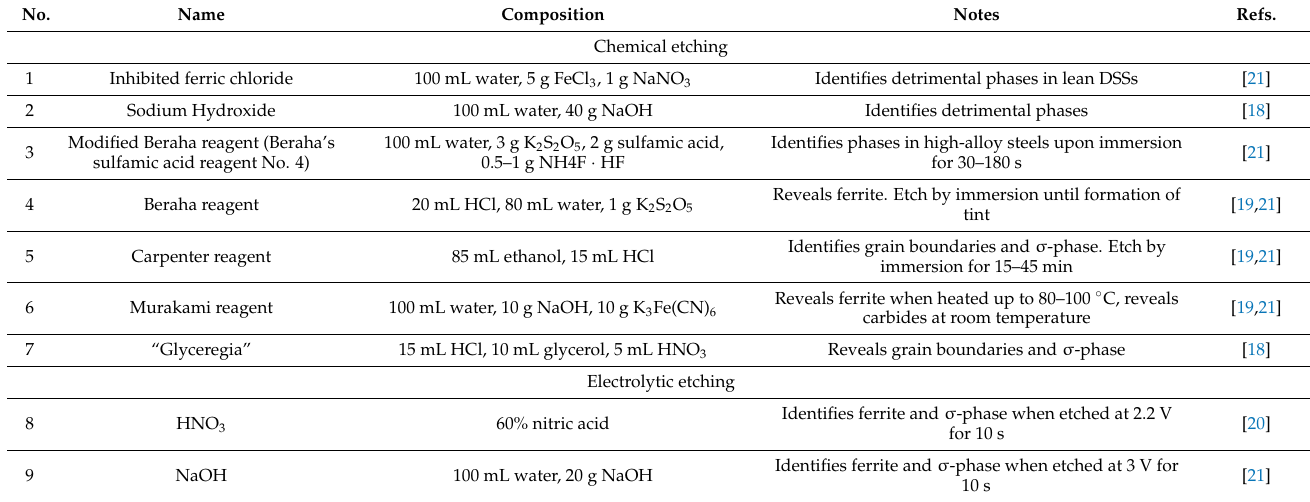
Table 2. Used etchants and features of their